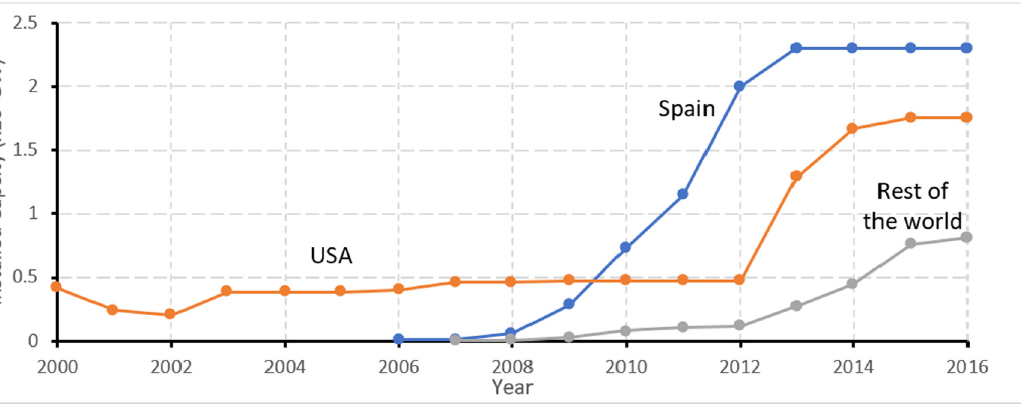
Figure 20: Time series of CSP plants installed capacity. ( Data retrieved from the Resource IRENA website: resourceirena.irena.org/ gateway/. )